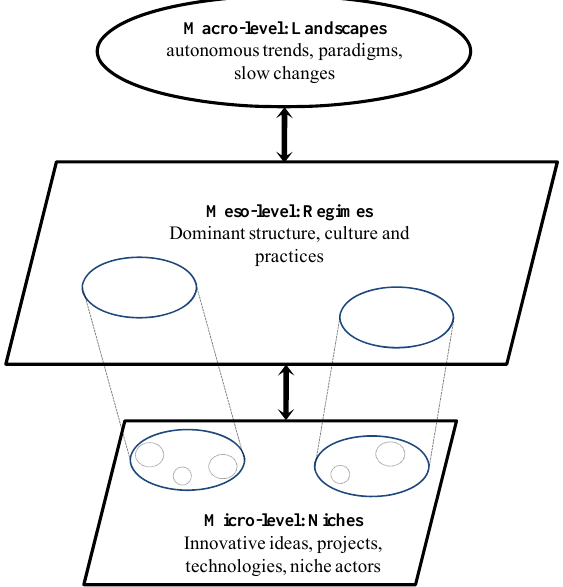
Figure 1. The multi-level perspective (MLP) framework, based on Loorbach and Wijsman [4] (p.